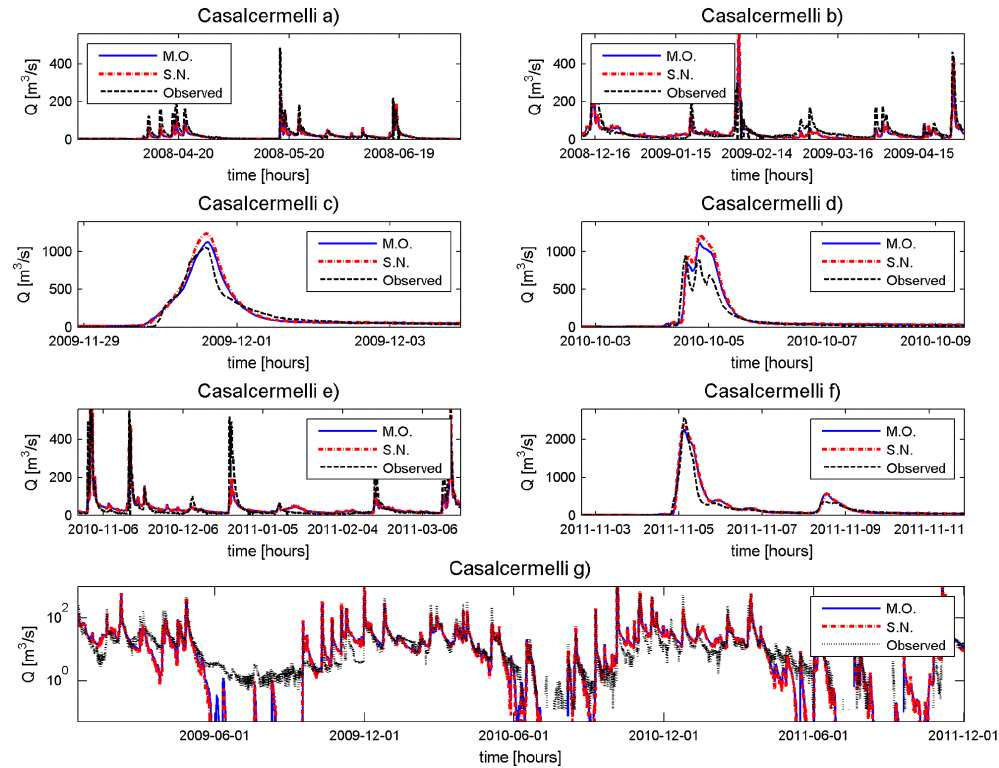
Figure 13. Observed streamflow for the Orba basin compared with simulations obtained using the M. O. and S. N. parameter sets for the period 2009 to 2011. Time is reported on x axis and streamflow on y axis. The bottom subpanel shows the entire period with log scale on y axis. The other subpanels show the main flood events with linear scale on y axis.